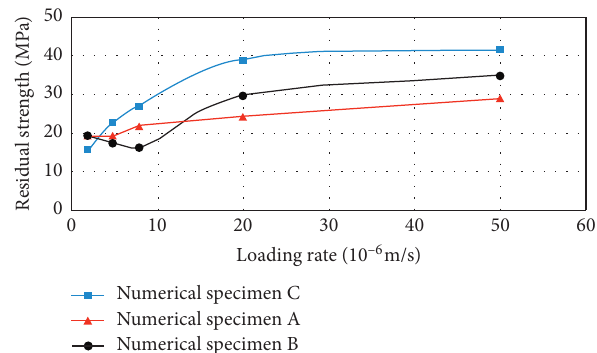
Figure 6: Relationship curve between residual strength and loading rate.